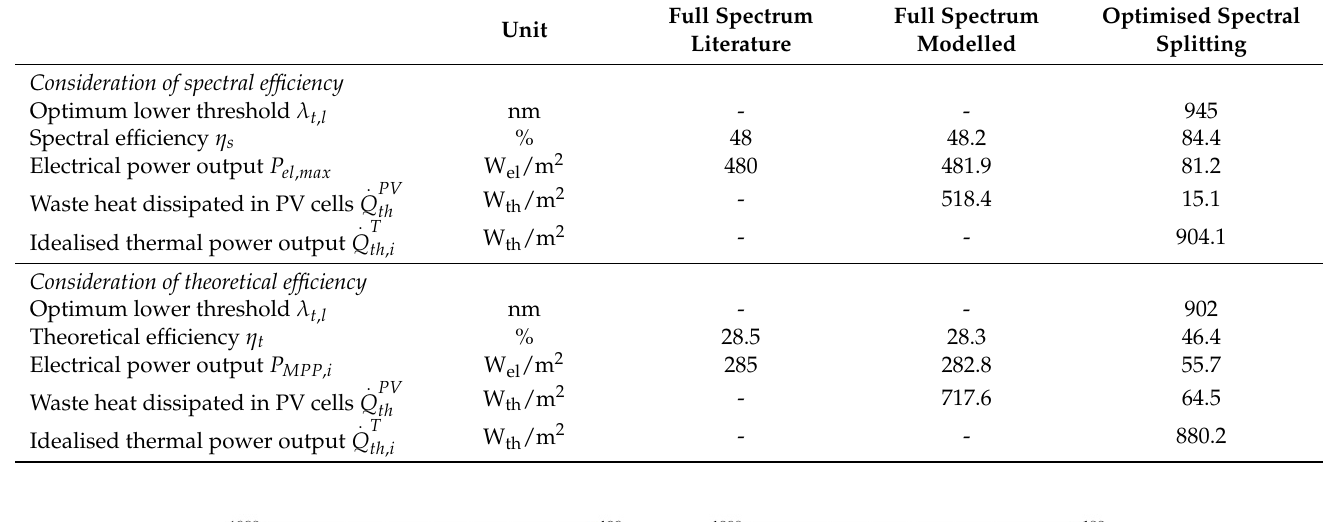
Table 1. Comparison of key parameters at full spectrum and at optimum Spectral Splitting configuration for c-Si PV technology.